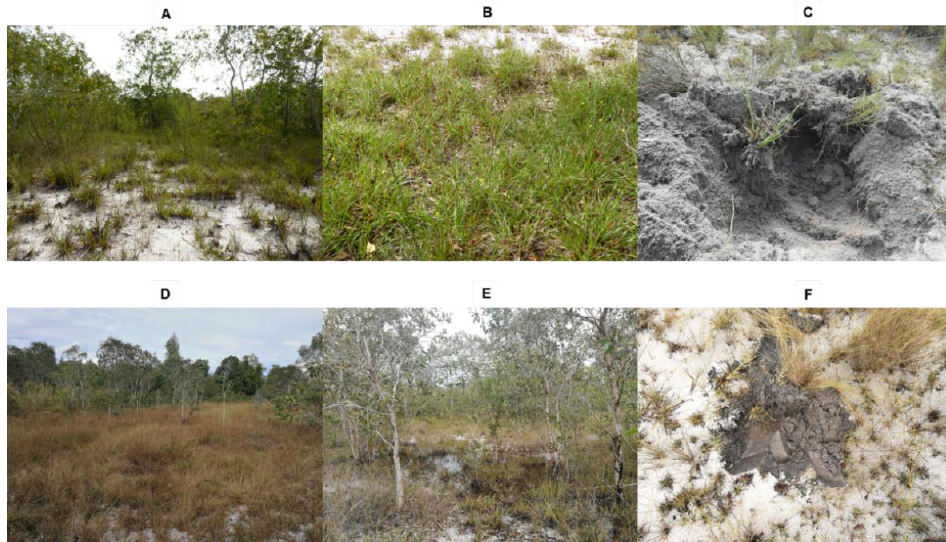
Figure 1. The vegetation of coastal sand dunes during the dry and wet seasons. The coastal sand dune was in Hatyai, Songkhla, Thailand. The vegetation of the study site shows X. complanata as the dominant plant species. In the dry season, X. complanata and other grasses were green ( A , B ). There was no belowground water accumulation ( C ). Conversely, in the wet season, X. complanata and other grasses were dry ( D ). Some areas of the study site were flooded ( E ). In non-flooded areas, water accumulated heavily below ground ( F